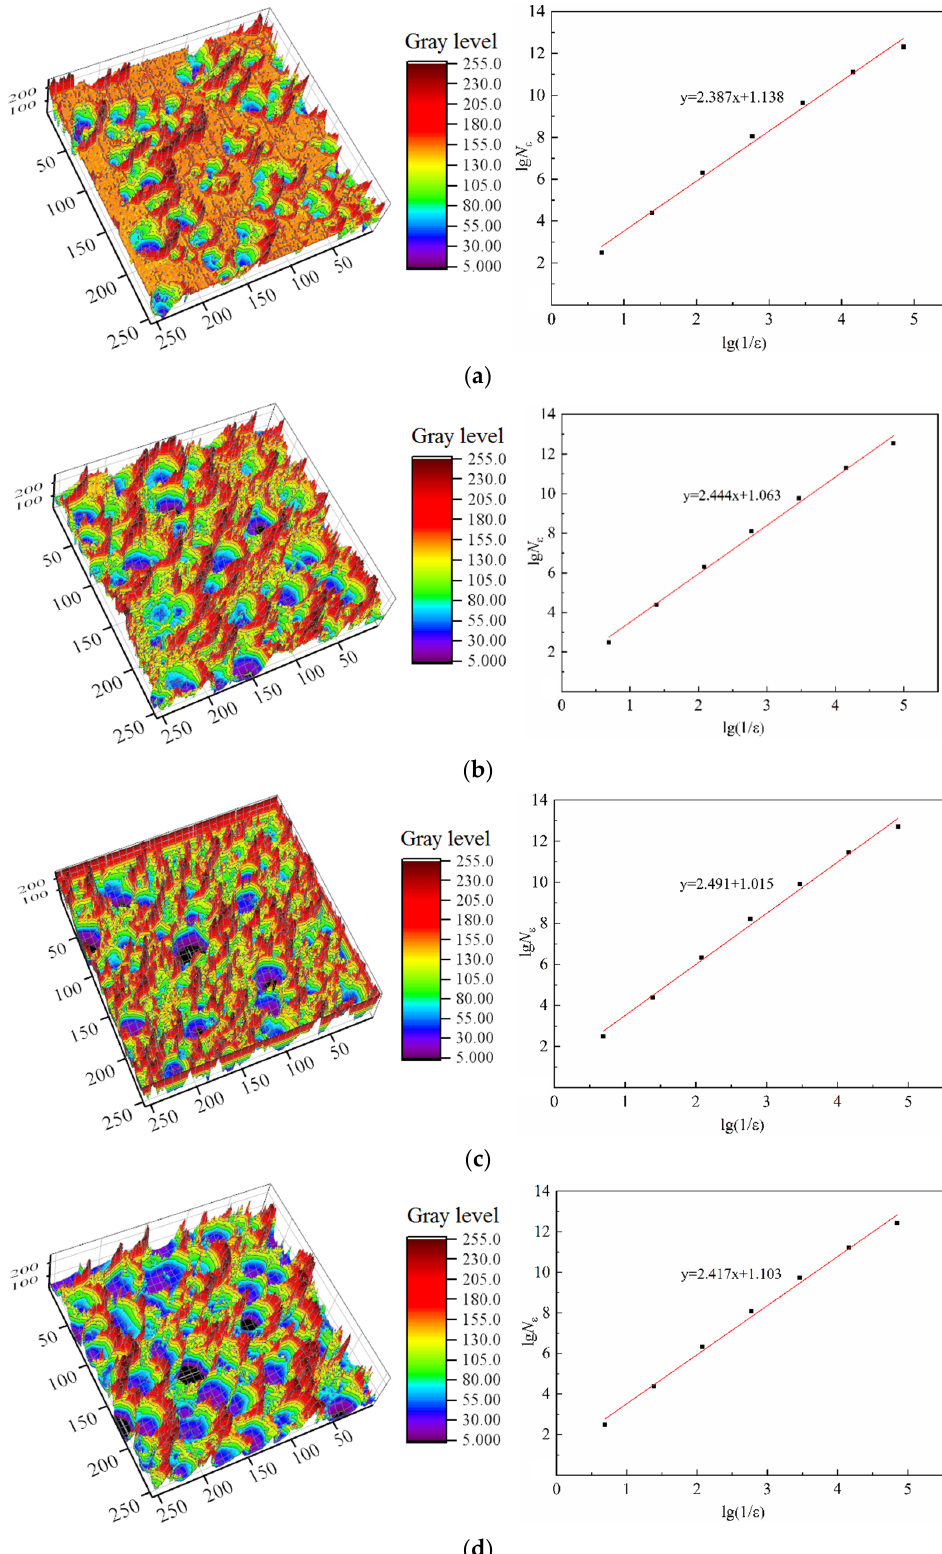
Figure 6. Three-dimensional corrosion morphology image and fractal dimension calculation diagram: ( a ) 50% [Cl − ] Std ; ( b ) 100% [Cl − ] Std ; ( c ) 150% [Cl − ] Std ; ( d ) 200% [Cl − ] Std .